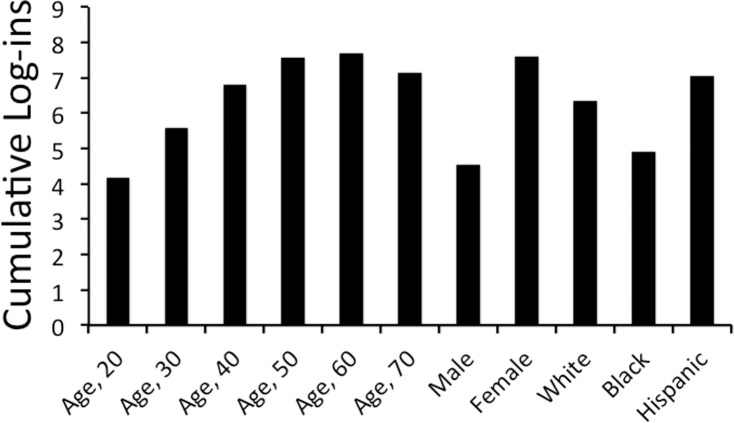
Predicted means of log-ins adjusted for age, gender, job type, employer, ethnicity, state, baseline weight, baseline systolic blood pressure, baseline glucose, and baseline lipid status.